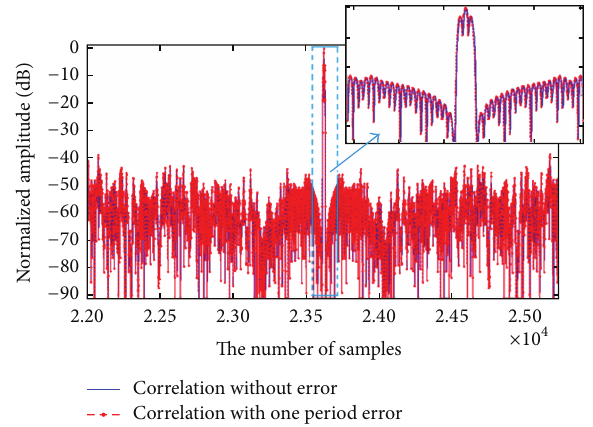
Figure 6: Comparison between the cross-correlation of the 𝑚 - sequence with 2047 chips with one-period estimation error and that of 𝑚 -sequence with no estimation